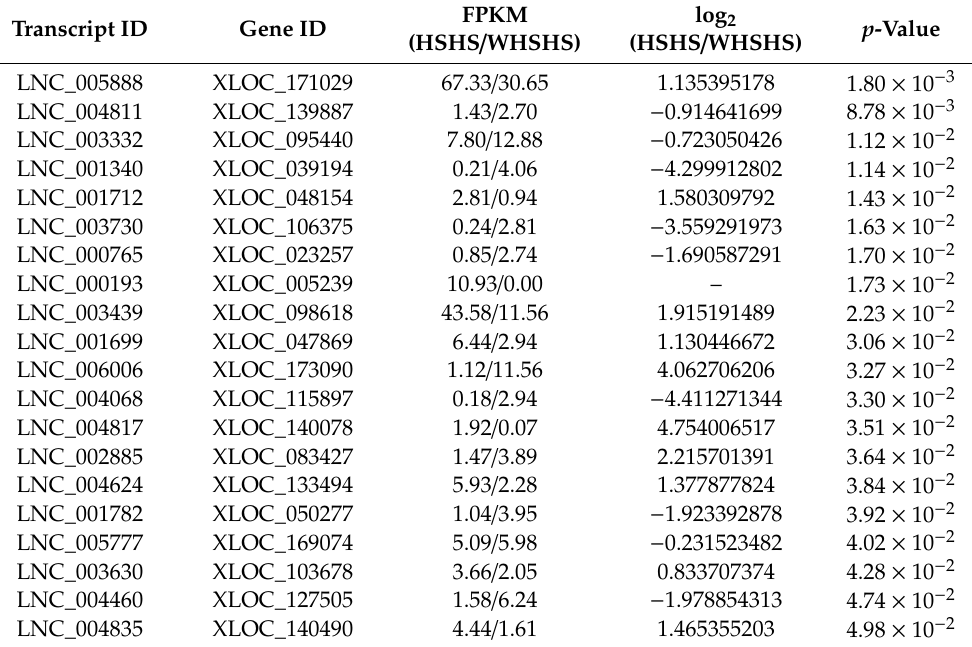
Table 5. The 20 di ff erentially expressed lncRNAs in the liver of the Hu sheep.